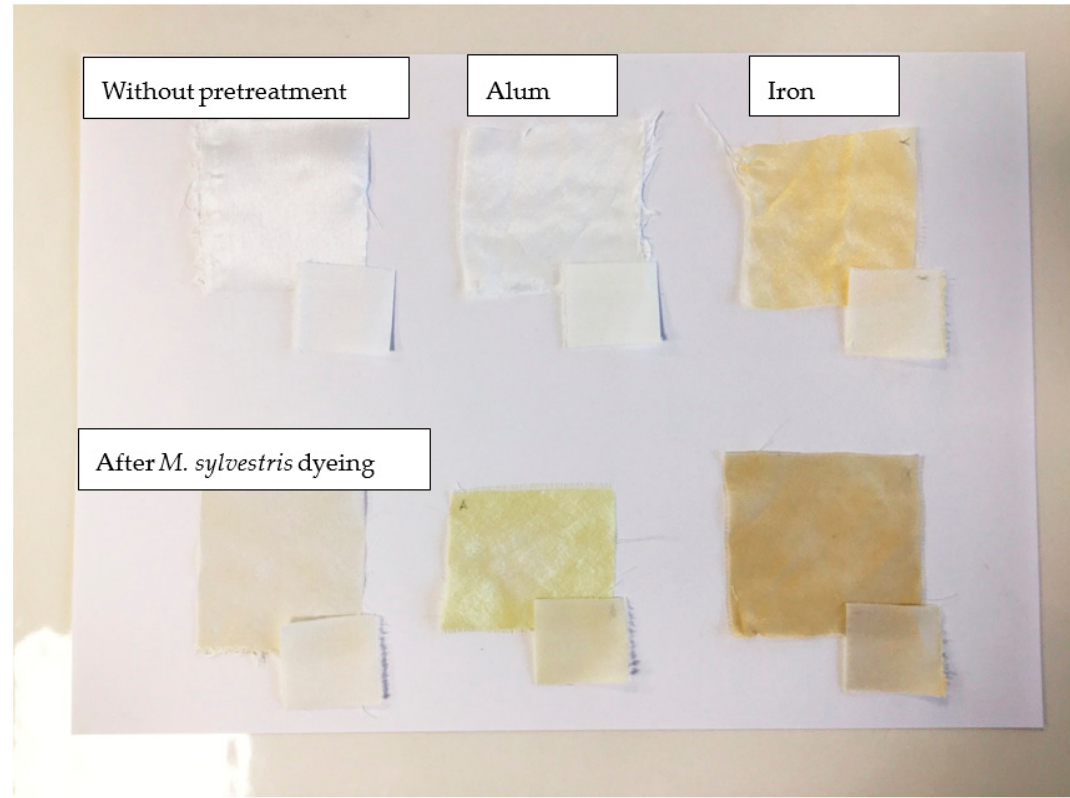
Figure 3. Color of the pretreated fabrics before and after the dyeing with Malva sylvestris L. extract. The small fabric squares are cotton, and the large fabric squares are silk.